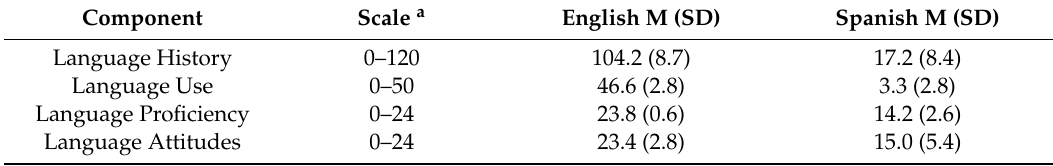
Table 1. Unweighted results of the Bilingual Language Profile (BLP) subcomponents.